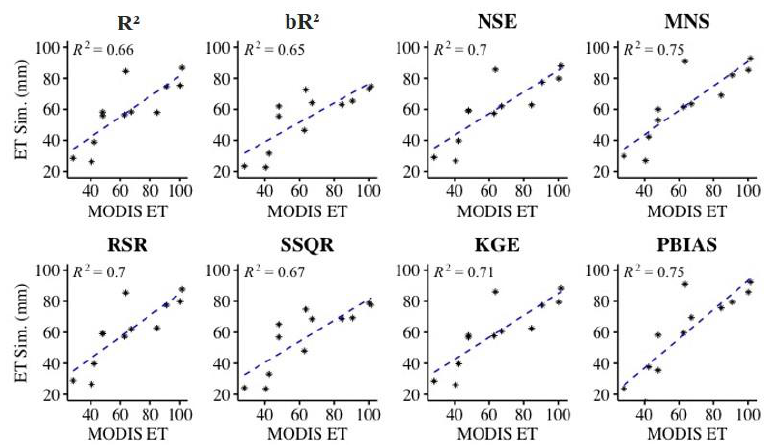
Figure 7. Linear regression between monthly average evapotranspiration obtained from the simulation results (ET Sim.) of different objective functions and monthly average evapotranspiration obtained from MODIS ET.